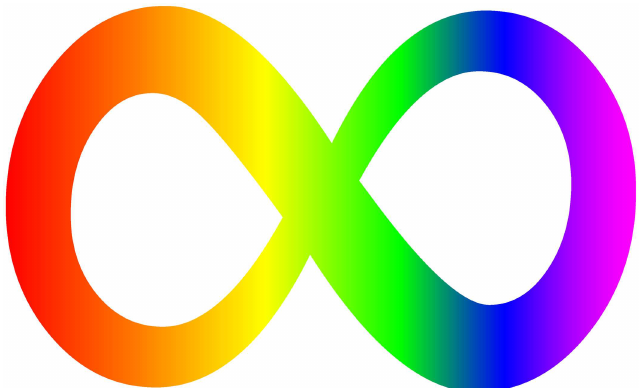
Fig 1. Many people with autism and their families like the rainbow infinity sign as a symbol of neurodiversity, representing not just the tremendous diversity of people on the spectrum but also of human cognitive and intellectual